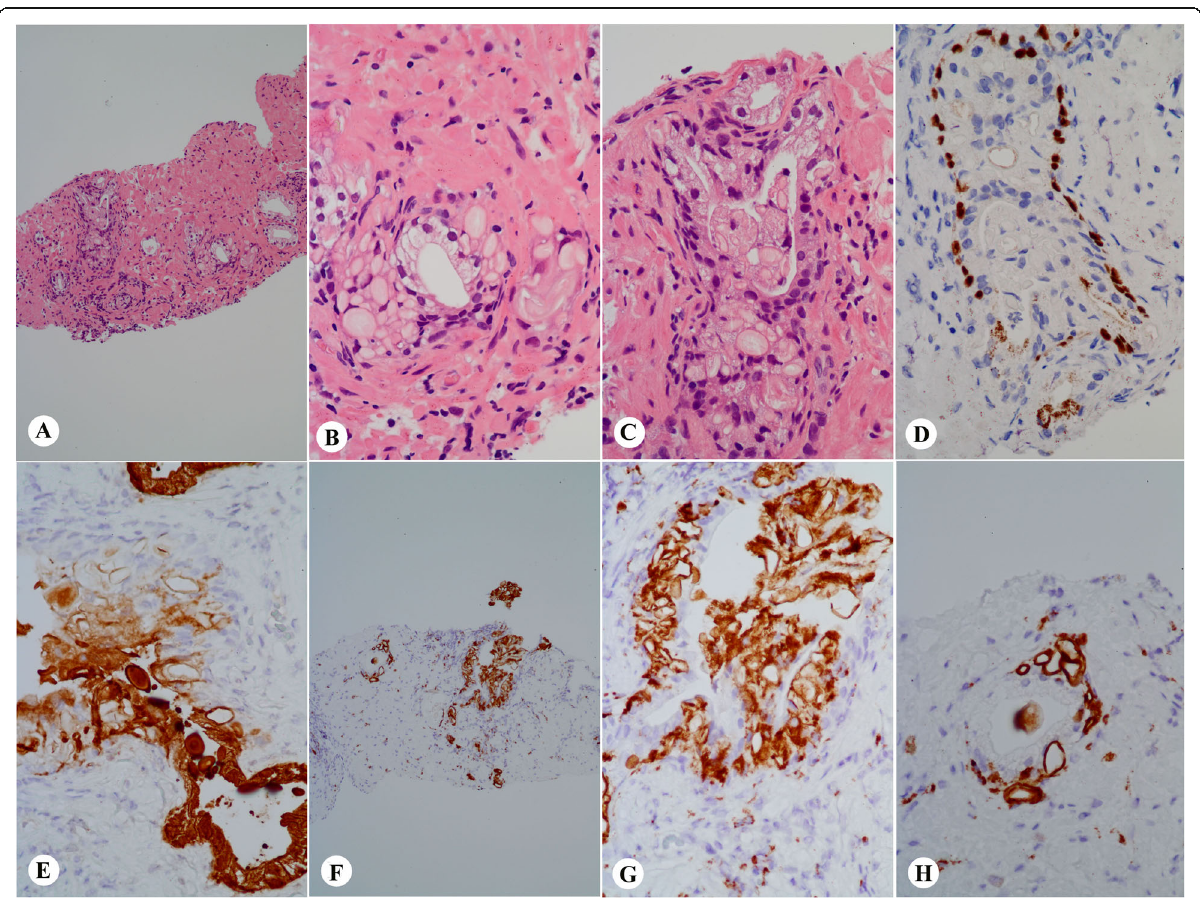
Fig. 3 Prostate biopsy with a lesion of infiltrative appearance within the stroma and glandular epithelium. Morphology of these cells are reminiscent of signet ring tumor cells (HE stain: a 100x; b 400x, c 400x). Glands show preserved basal cell layer ( d Cocktail P63 and high molecular weight cytokeratin 34bE12 – 400x). Signet ring-like cells do not express PSA, and negative PSA cells are seen infiltrating glandular epithelium (PSA immunohistochemistry: e 400x). Signet ring-like cells strongly express CD68 and infiltrates glandular epithelium (CD68 immunohistochemistry: f 100x, g 400x, h